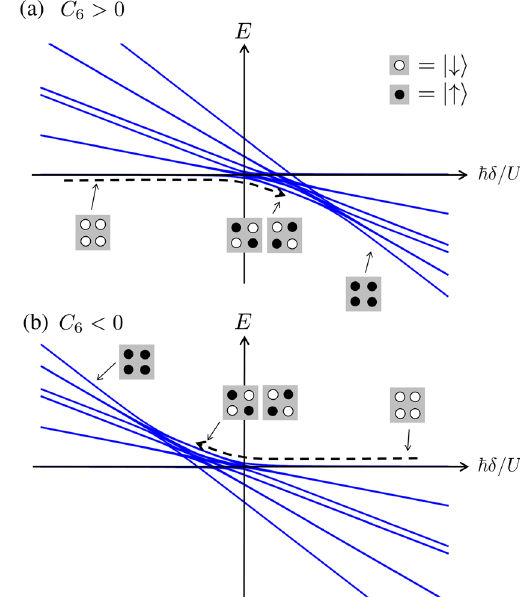
FIG. 6. Influence of the sign of C 6 on the many-body spectrum. Eigenenergies of a small 2 × 2 square system as a function of δ for ℏ Ω =U ≃ 0 . 5 . (a) For a repulsive interaction C 6 > 0 , the ground state of H is antiferromagnetic for 0 < ℏ δ < 2 U . It can be reached from j ↓ i ⊗ 4 by adiabatically following the ground state starting from negative values of δ (trajectory in dashed arrows). (b) For an attractive interaction C 6 < 0 , the antiferro- magnetic state is the most excited state, and the sign of the detuning needed to reach it from j ↓ i ⊗ 4 is reversed.